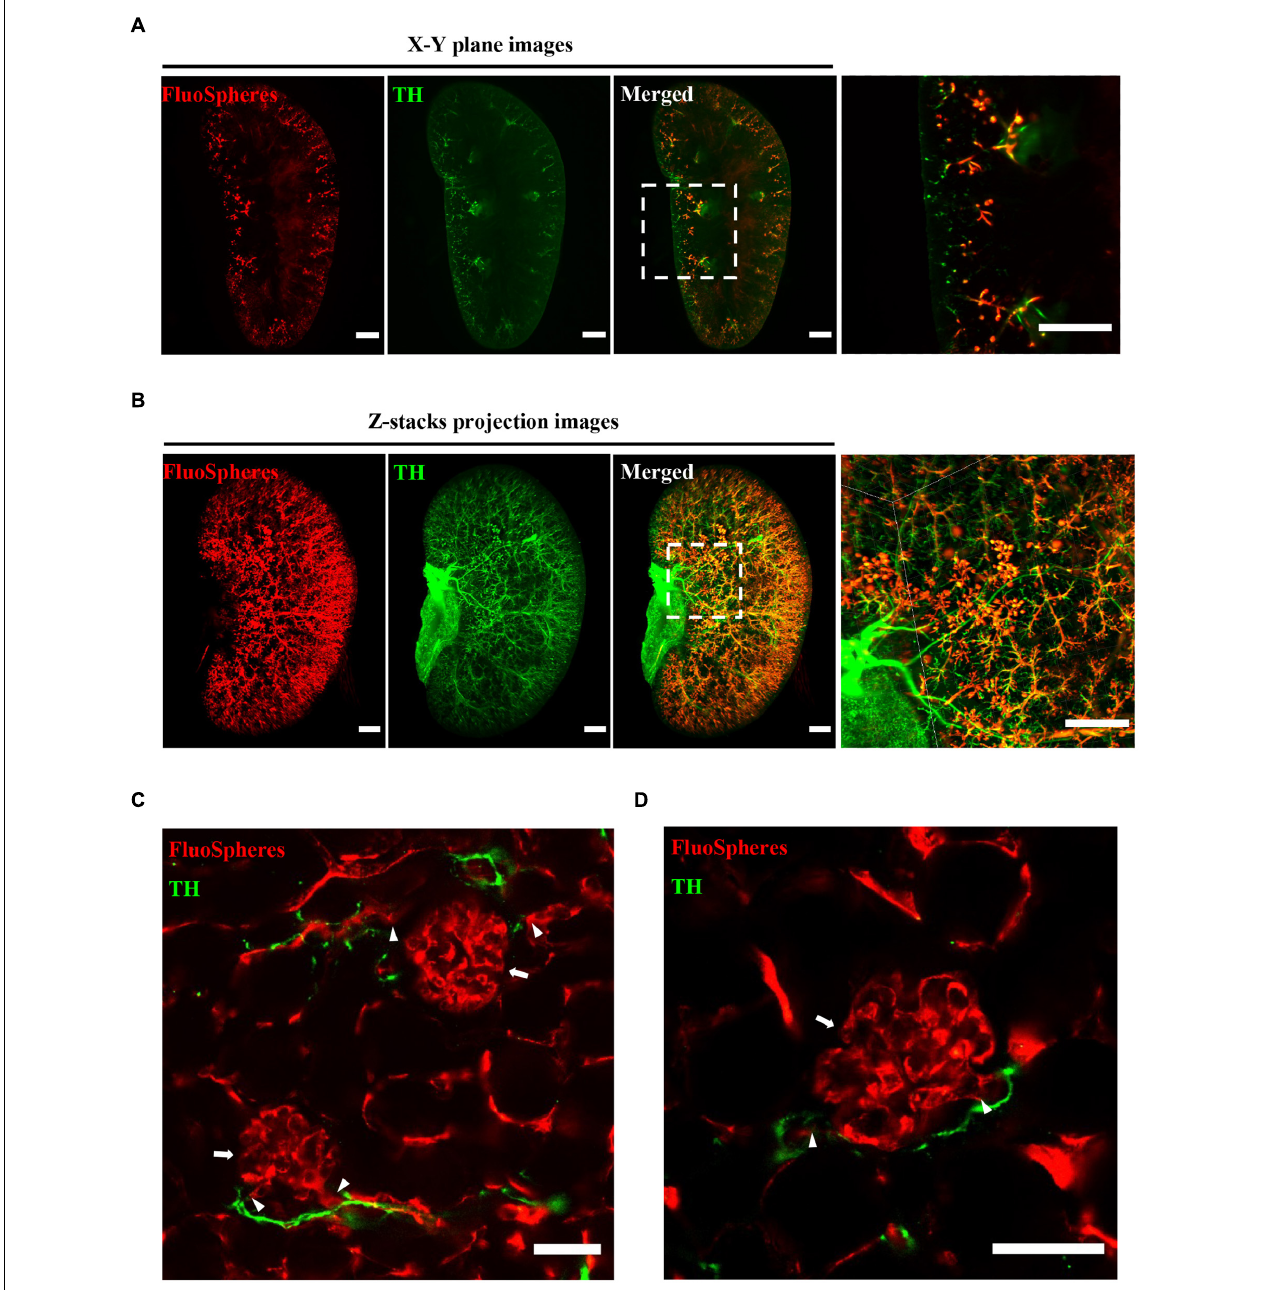
FIGURE 4 | Three-dimensional imaging illustrates the distribution of microvasculature and accompanying sympathetic nerves. The whole kidney was transcardially perfused with FluoSphere and subjected to anti-TH immunolabeling. (A) X – Y plane and (B) z-stack projection images showed the distribution of renal microvascular and accompanying sympathetic nerves. The z-stack projection included 1243 z-sections. The square areas are magnified. Sympathetic nerves traveled across the renal microvasculature to the glomerulus. Scale bar = 1 mm. (C,D) Representative images of the glomerulus (arrow), connected afferent/efferent arteriole (triangle), and accompanying sympathetic nerves (TH-positive). Scale bar = 50 µ m. Sympathetic nerves were labeled with TH (green). The microvasculature was labeled with FluoSphere (red).